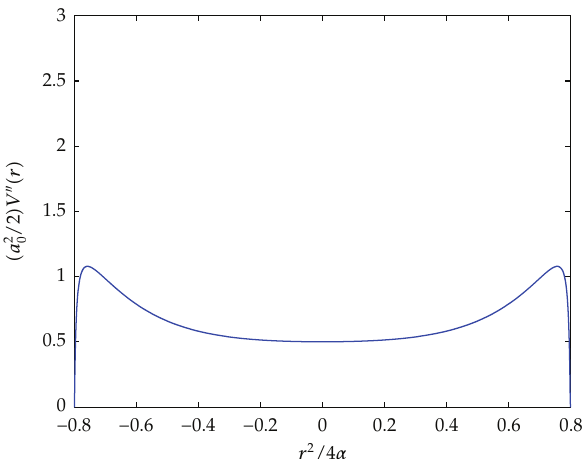
Figure 6: The de Sitter wormhole with Λ M 2 (cid:5) 0 . 045 and α (cid:5) 0 .